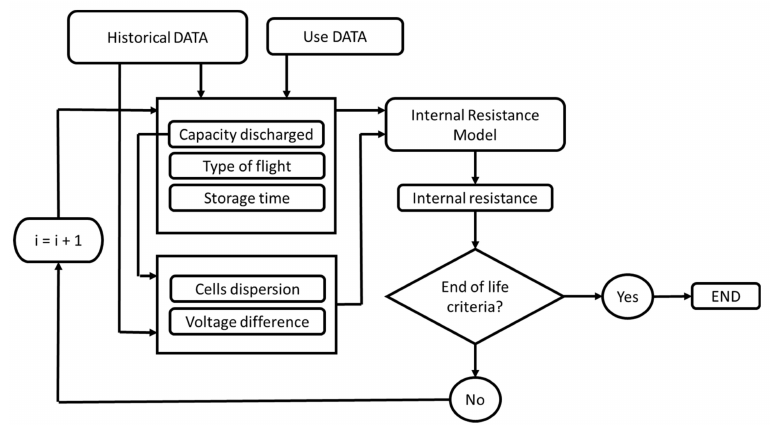
Figure 26. Prediction model flow